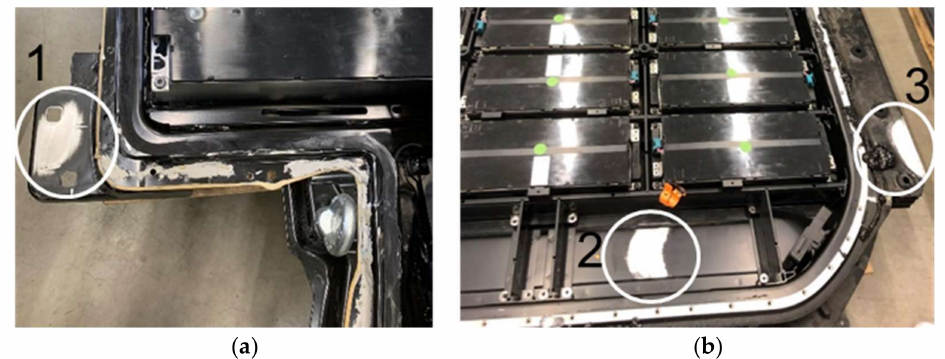
Figure 19. Presentation of the measuring points of the two different battery housings: ( a ) VW pack measuring point 1 carrier and ( b ) Audi e-tron measuring point 2 housing below a module and measuring point 3 carrier.